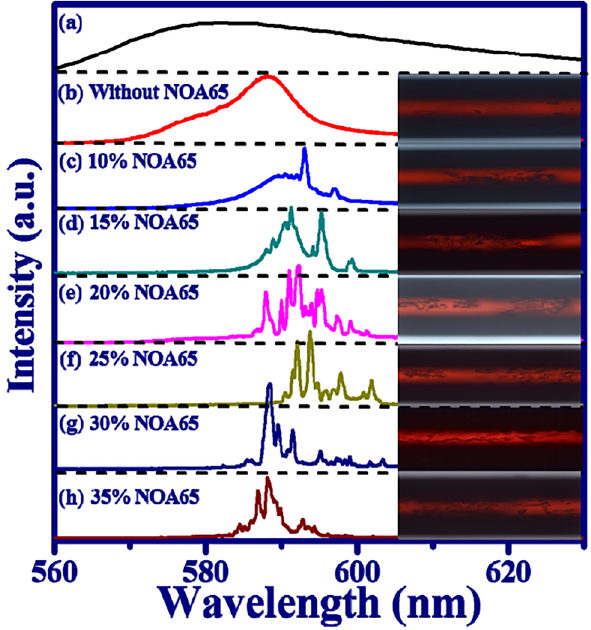
Figure 14: (a) The RT-PL of laser dye (PM597) and the RT stimulated emission spectra from the capillary tube through exciting the Q - switched laser that contains the DD-LC mixtures (b) without mono- mer and with (c) 10 wt.%, (d) 15 wt.%, (e) 20 wt.%, (f) 25 wt.%, (g) 35 wt.%, and (h) 35 wt.% monomer doping concentrations. The POM pictures of the DD-PDLCs are shown on the right of each diagram